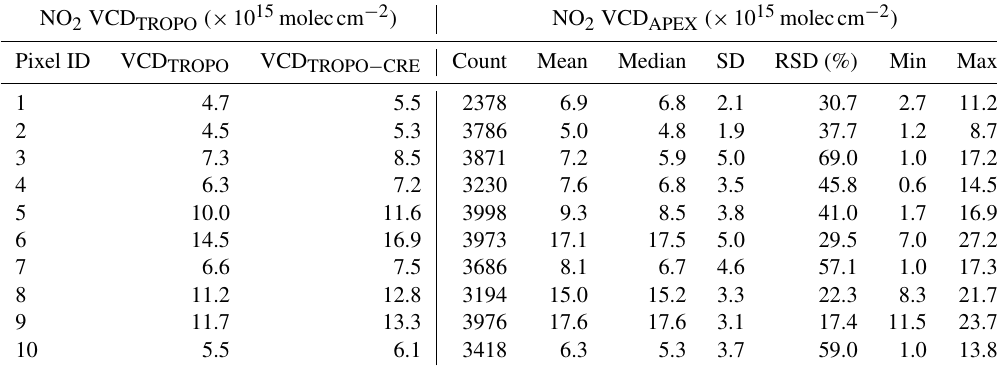
Table A4. Tropospheric NO 2 VCD statistics for coincident TROPOMI and APEX pixels for Flight no. 4, orbit